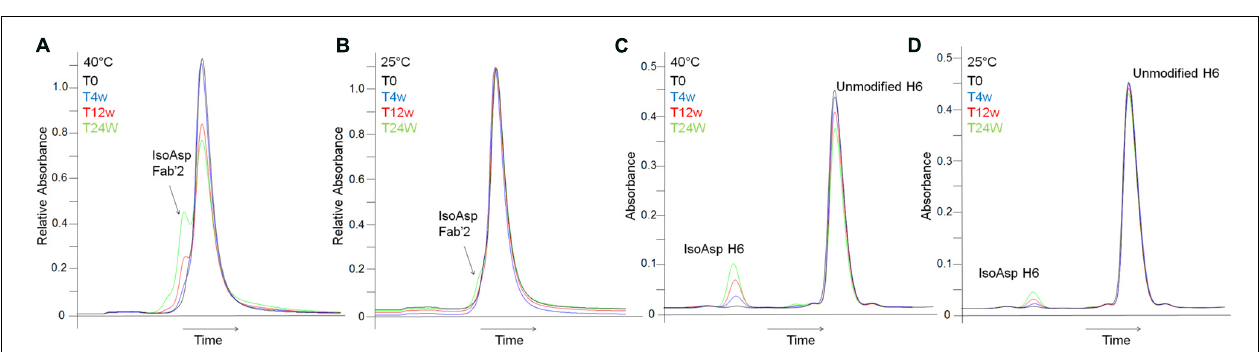
FIGURE 4 | Detection of isoAsp by intact HIC separation and focused peptide map. HIC of stability samples held at 40 ◦ C (A) or at 25 ◦ C (B) . A214 nm trace from the focused peptide map of stability samples held at